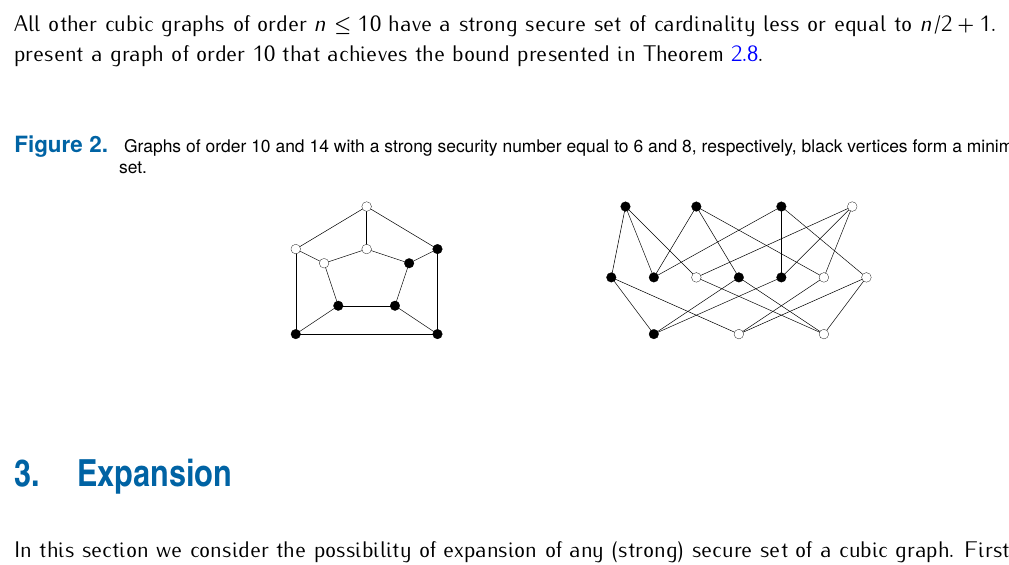
All other cubic graphs of order n ≤ 10 have a strong secure set of cardinality less or equal to n/ 2 + 1. In Figure 2 we present a graph of order 10 that achieves the bound presented in Theorem 2.8.